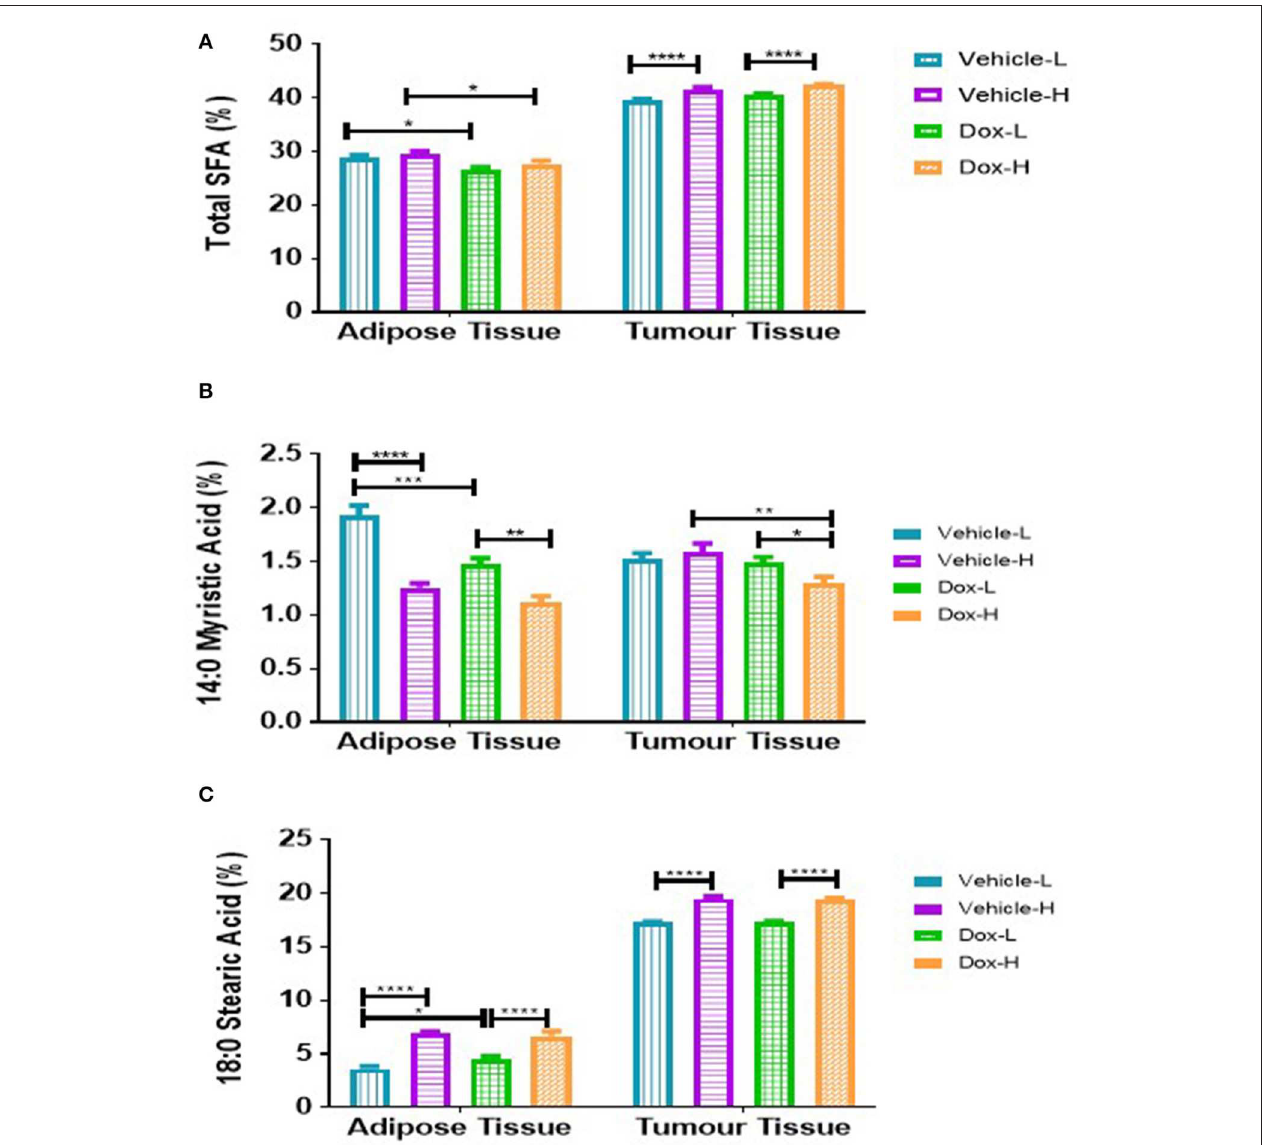
FIGURE 9 | Saturated fatty acid composition; (A) Total SFA, (B) Myristic Acid, and (C) Stearic Acid of mammary adipose- and tumor tissue of mice fed a LFD or HFD with either vehicle control or doxorubicin treatment. Results are presented as mean ± SEM ( n = 5). Two-way ANOVA with Fisher’s LSD post hoc correction was applied and p < 0.05 was considered as statistically significant. * p < 0.05, ** p < 0.01, *** p < 0.001 and **** p < 0.0001.